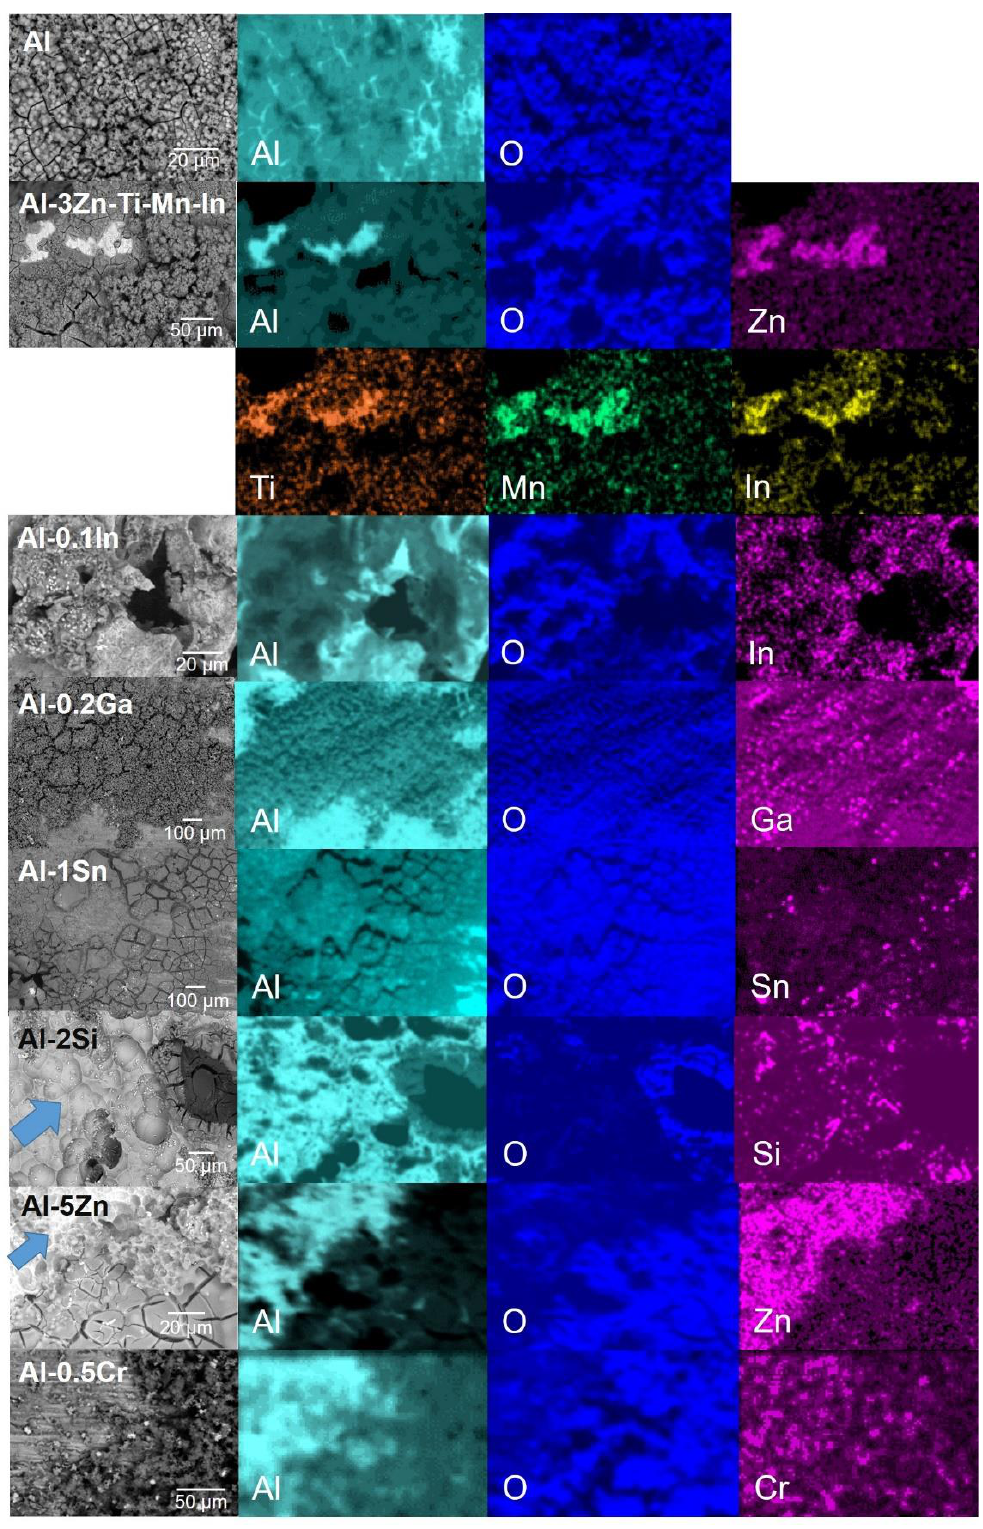
Figure 10. SEM-EDS elemental maps of the corrosion product film formation on the Al-based alloys after galvanic coupling with mild steel in 3.5 wt.% NaCl solution; blue arrows show corrosion- product-free regions.